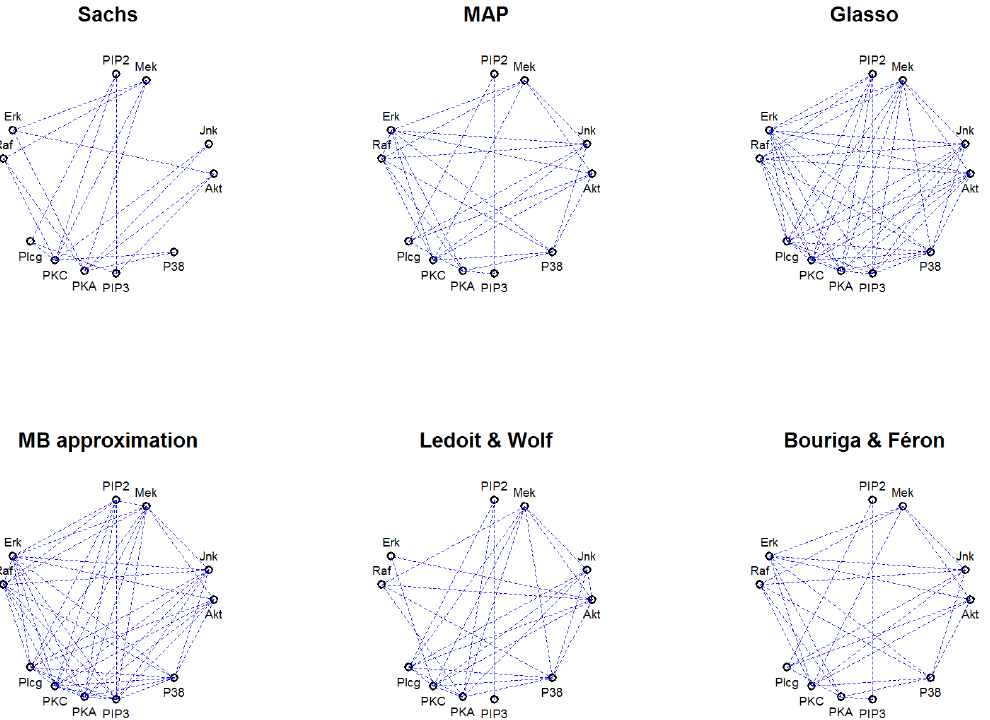
Fig 8. Undirected graphs from cell-signaling data. The original undirected graph from [13] (Sachs) and GGMs estimated with MAP with diminished condition number and decision-rule (MAP), graphical lasso (Glasso), Meinshausen and Bühlmann approximation (MB approximation), Ledoit and Wolf estimate with our decision-rule (Ledoit & Wolf) and posterior for Θ estimated with the model 1 introduced by Bouriga and Féron with our decision-rule (Bouriga & Féron).